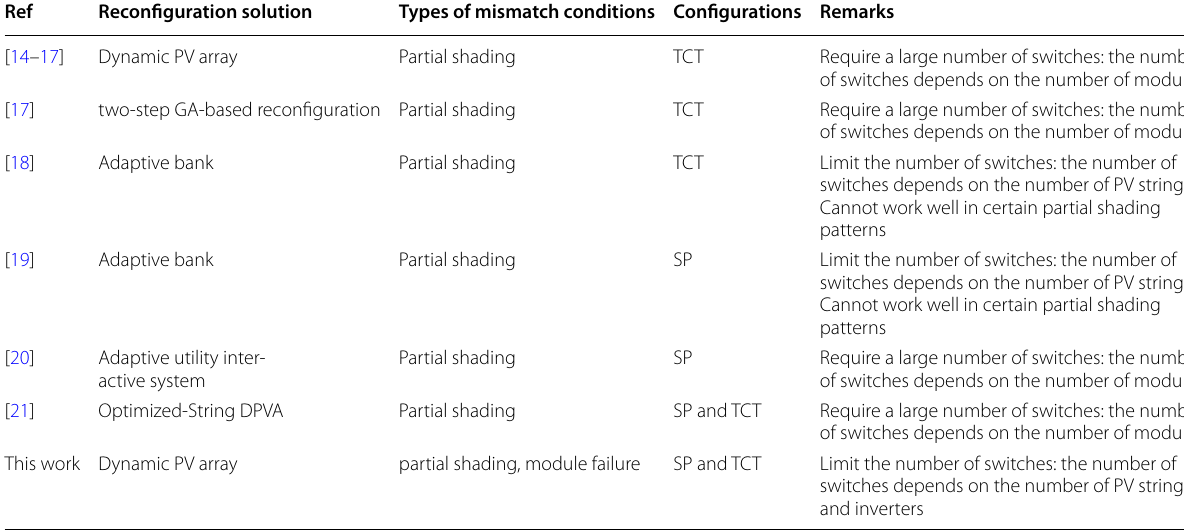
Table 1 Summary of dynamic topology reconfiguration solutions Ref Reconfiguration solution